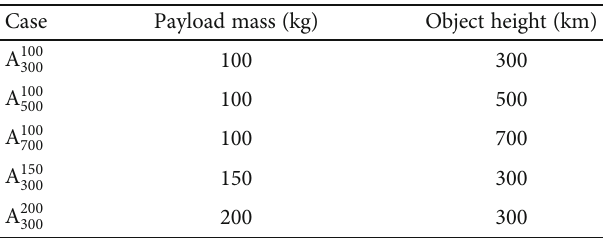
Figure 15: Self-organizing map of case A: (a) M Table 9: Payload mass and orbit height of each